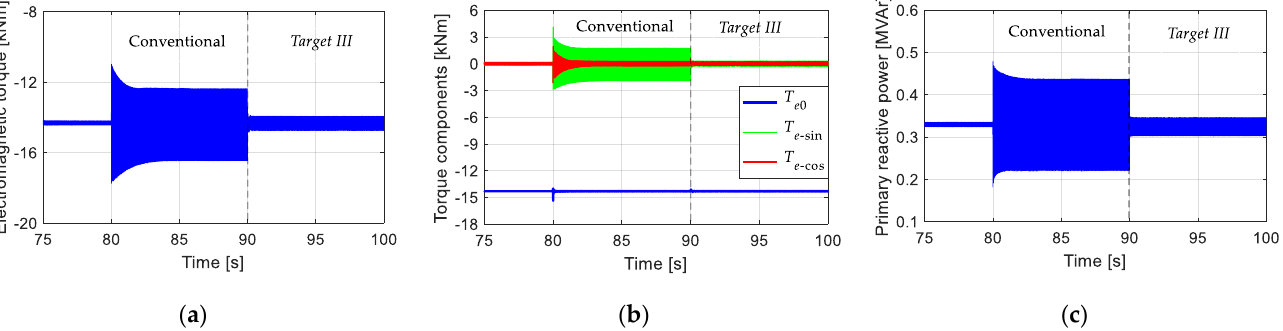
Figure 10. Simulation results comparison with Target II for primary active power ripple elimination. ( a ) Primary active power response; ( b ) Active power components.